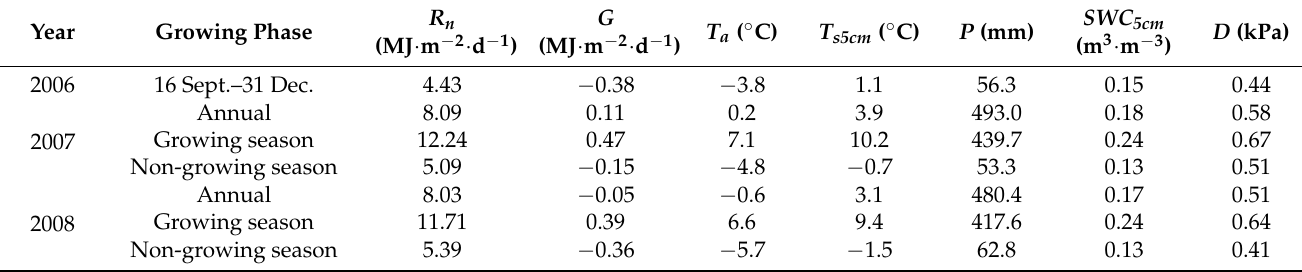
Table 1. Comparison of environmental conditions during the growing and non-growing seasons at the study site.